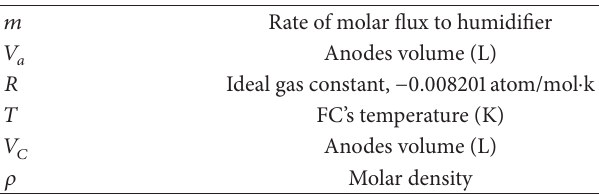
Table 1: Definitions of the symbols used in